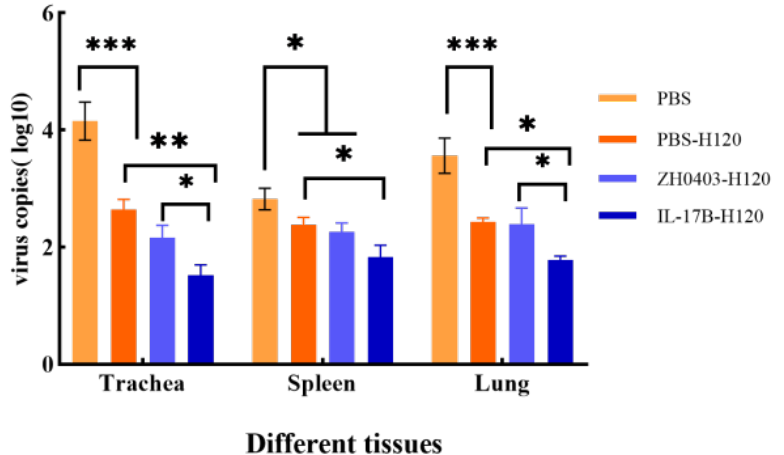
Figure 11. Viral RNA load level in trachea, kidney, and liver determined via absolute quantitative qRT-PCR. One- way ANOVA with Tukey’s test was used for statistical analysis; * : p < 0.05; **: p < 0.01, ***: p < 0.001.